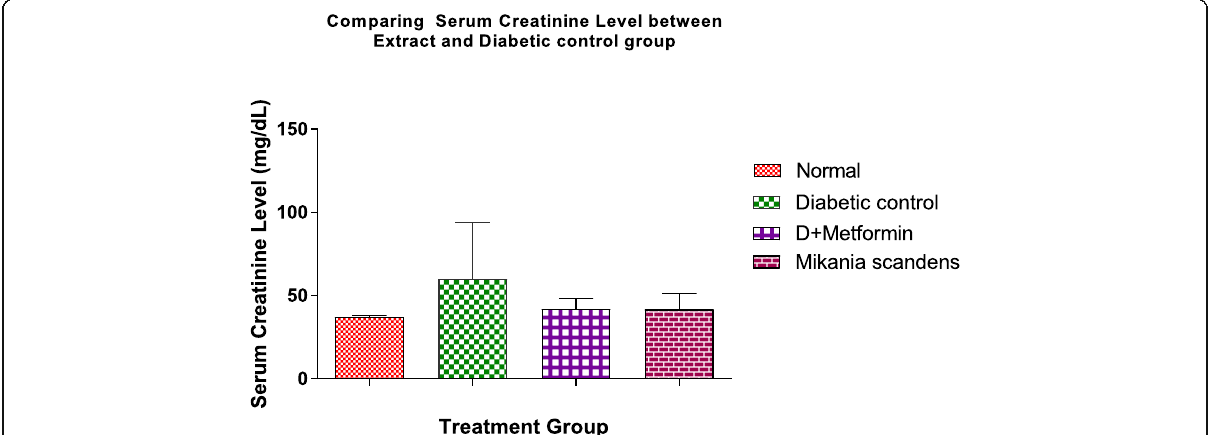
Fig. 3 Comparing serum creatinine level among diabetic control, metformin HCL and Mikania scandens animal groups. Significant different ( p < 0.05) from the diabetic control. Data were analyzed by one way ANOVA followed by scheffe ’ s post-hoc test